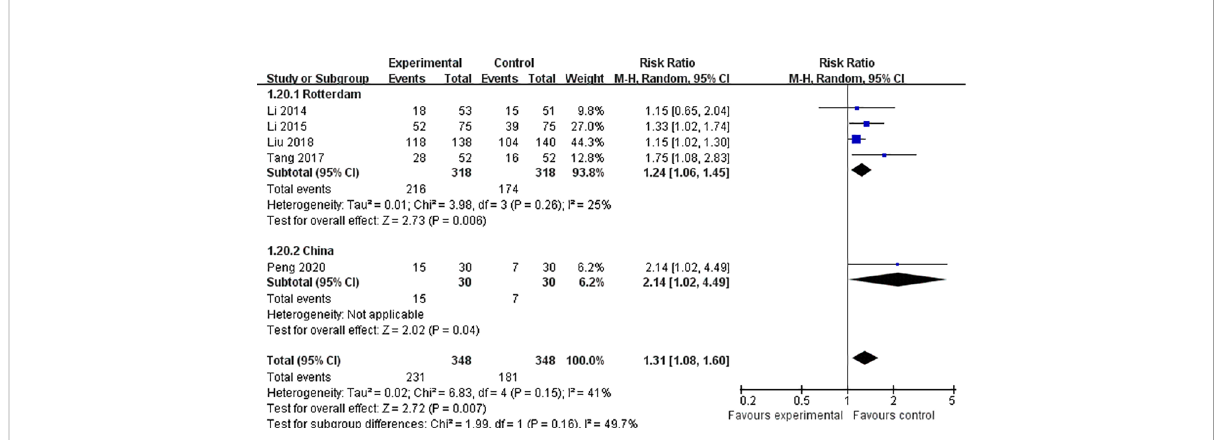
FIGURE 5 Forest plot of effects of acupuncture combined with metformin versus metformin alone on pregnancy rate (diagnostic criteria of